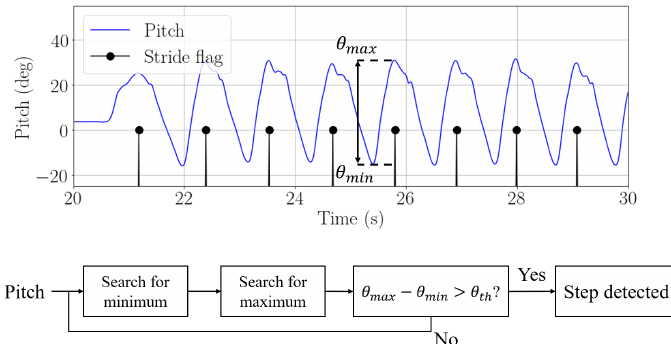
Figure 7. Pitch estimation (blue) and detected strides (black) when the passenger carries the smart- phone in the front pocket of the trousers and algorithm for step